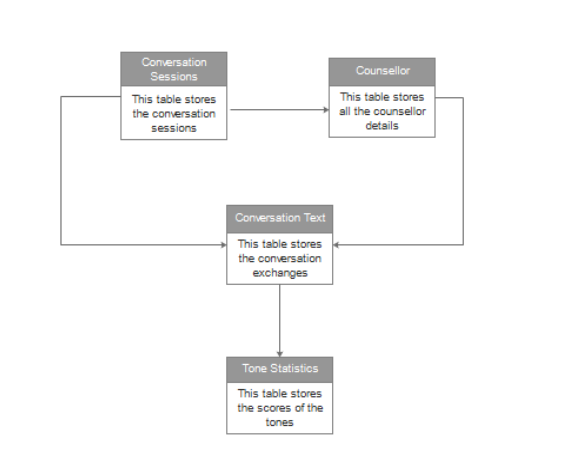
Figure 9. Conceptual Database